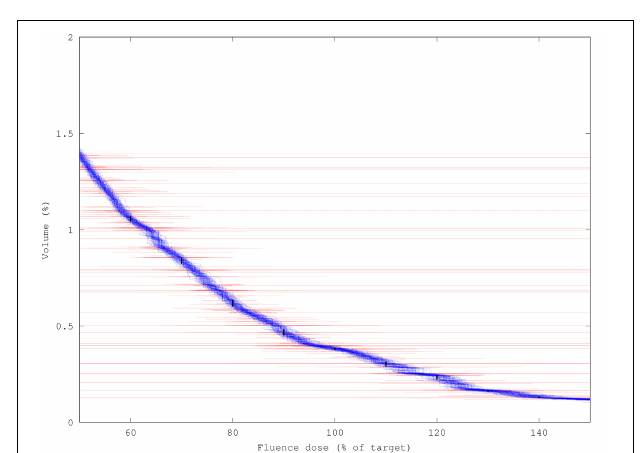
FIGURE 6 | Variance-reduction effect of DVH generation demonstrated by overlaying 100 DVHs for muscle tissue at risk, each created from a run of 100k packets (1.3s runtime each), on top of ± σ bars (red) for each individual fluence component. Black bars show ± 1 σ uncertainty in determining the volume of tissue V p receiving more than p % of target dose ( p = 60 , 70 , ...140); uncertainties range from 1–5% of V p tissue